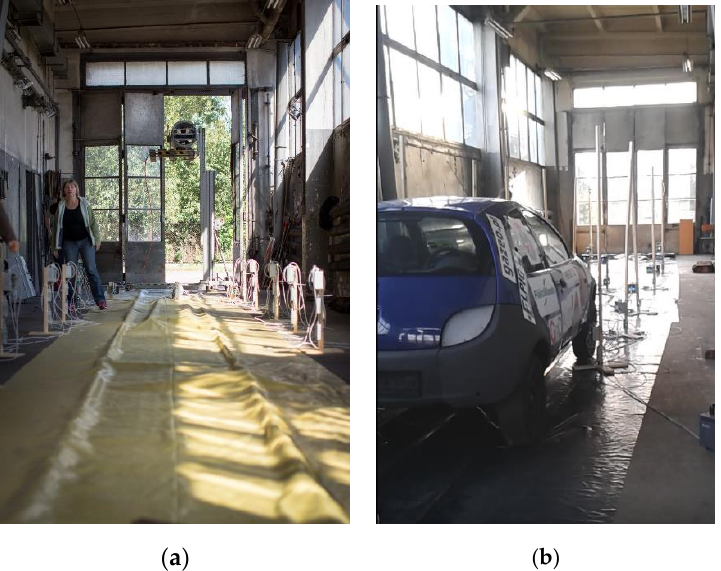
Figure 8. Photos of the measurement layout for the LPG experiments: ( a ) the full enclosure view, ( b ) the car body and measurement instruments.